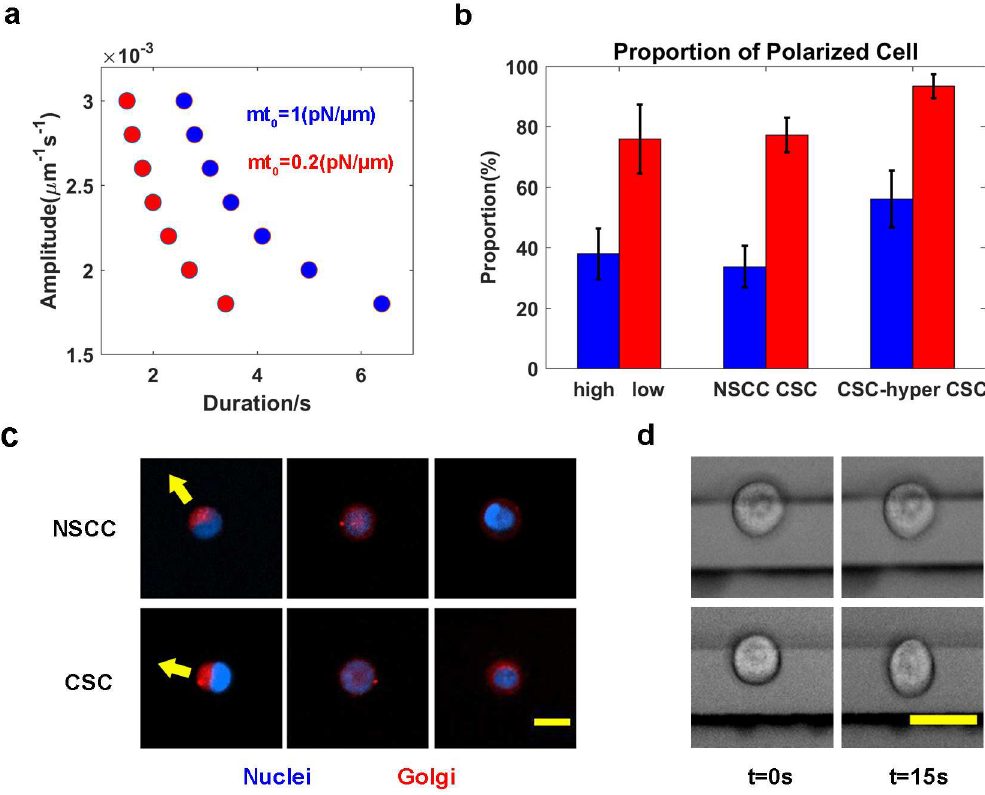
Fig 2. A lower membranetension increasesthe tendency of the cell to polarize. (a) Thresholdrelationship betweenthe amplitudeand durationof stimuli for inducingcell polarity at different values of membranetension. (b) The comparisonof the proportionof polarized cells with low and high membranetension in the simulation(left panel), of CSCs and NSCCs (middlepanel), and in the experiment examiningCSCs culturedin hypotonicmedium (right panel). Error bars represent the standarddeviation. (c) Representative images of polarized(left column)and nonpolarized (right two columns) NSCCs (top) and CSCs (bottom) on circularECM patterns. Scale bar: 20 μ m . In polarized NSCCs and CSCs, the Golgi (red) aggregateson one side of the nucleus(blue). However,in the nonpolarized NSCCs and CSCs, the Golgi (red) dispersesthroughoutthe cell (middle)or forms a ring aroundthe nucleus(blue). (d) Comparisonof relativecell deformation of NSCCs (top) and CSCs (bottom). Scale bar: 20 μ m . Both CSCs and NSCCs have a round shape, as they are trapped by the electrodes(the two horizontal bars) with an electric field of 2 V (left). CSCs elongatemuch more than NSCCs along the directionof the electric field after the electric field is increasedto 5 V for 15 s